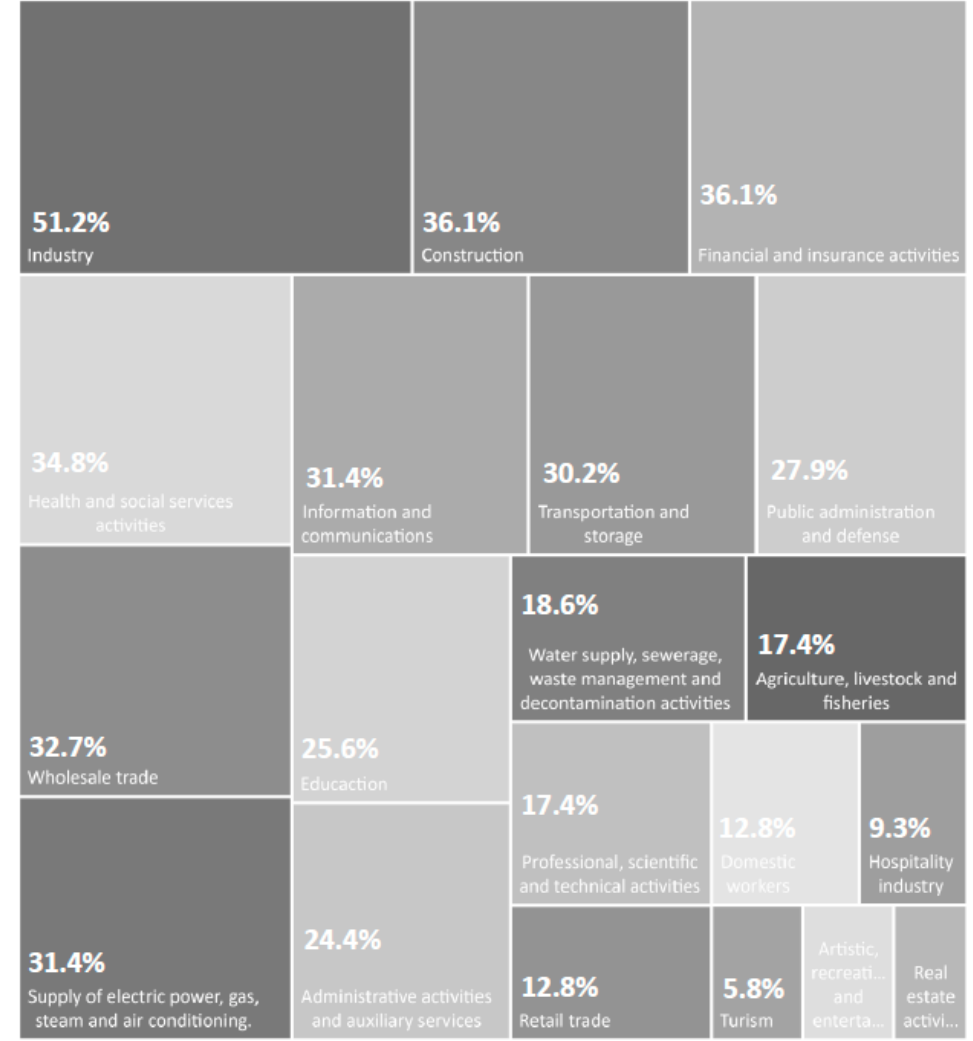
Figure 4. Sectors of activity that are expected to recover first according to the entities’ selection in terms of the total responses received. terms of the total responses